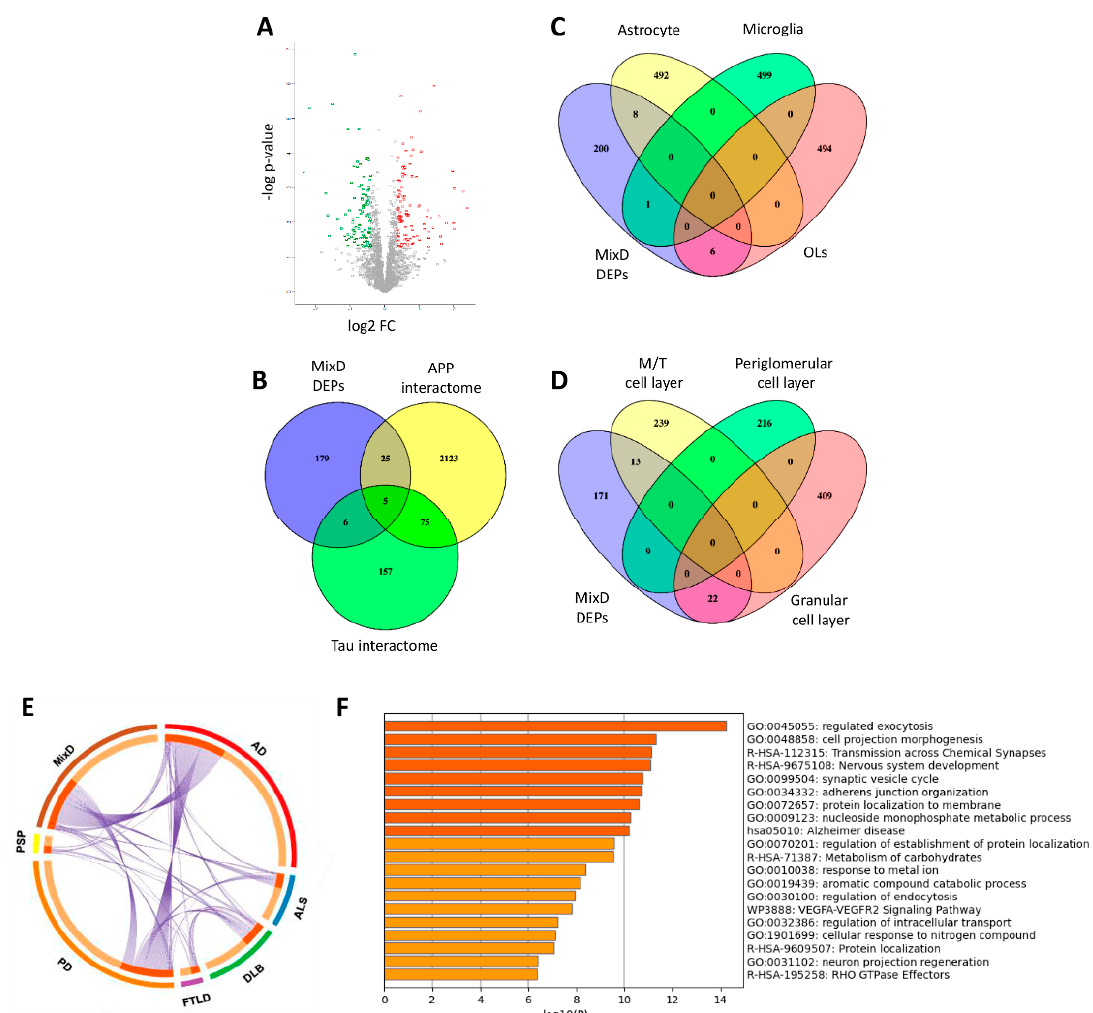
Figure 1. Olfactory proteome-wide analysis in MixD. ( A ) Volcano plot indicating the statistically significant DEPs represented in red (upregulation) and green (downregulation). ( B ) Venn diagram showing the overlap between OB DEPs and experimentally demonstrated APP and Tau interactors. ( C ) Cluster-enriched genes in specific brain cells that are differentially expressed in the OB from MixD subjects. ( D ) Cluster-enriched genes in specific OB cell layers that are deregulated in MixD at the level of the OB. ( E ) Circos plot representing commonalities in DEPs (purple lines) between MixD and different neurological phenotypes: AD, Parkinson’s disease (PD), Dementia with Lewy Bodies (DLB), Progressive supranuclear palsy (PSP), Amyotrophic lateral sclerosis (ALS), frontotempral lobar degeneration TDP-43 proteinopathy (FTLD-TDP43). ( F ) Top-20 statistically enriched terms from MixD DEPs generated by Metascape.